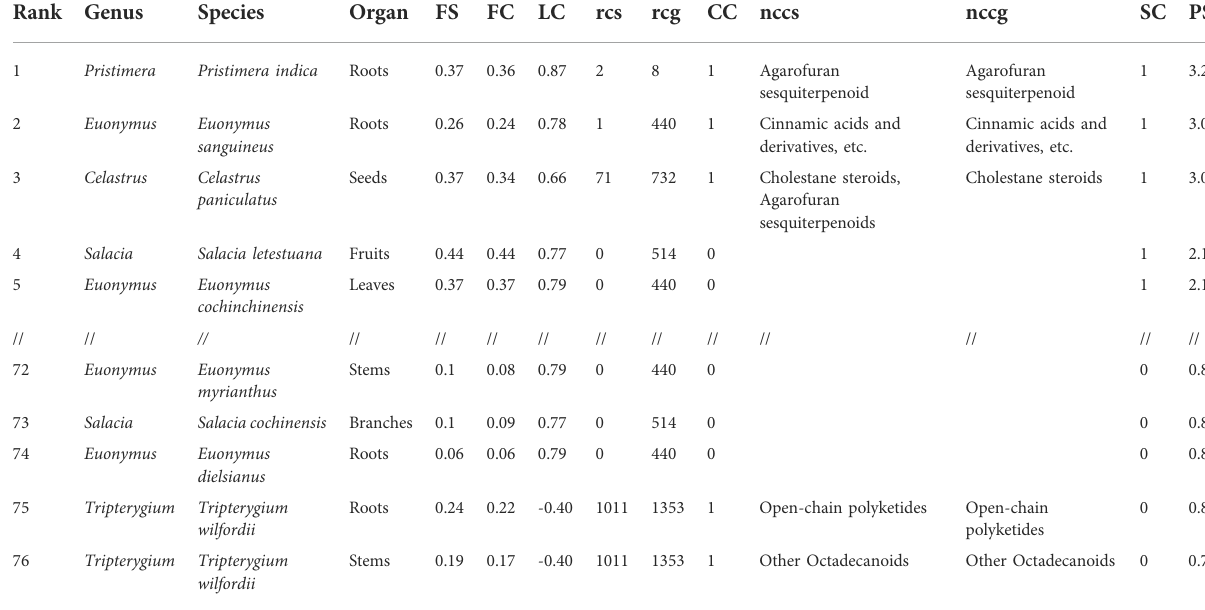
TABLE 1 Top and lowest fi ve results from the application of Inventa on the Celastraceae set. It shows a summary of the most representative results including the number of reported compounds in the species (rcs) and in the genus (rcg), the new chemical class in the species (nccs) and in the genus